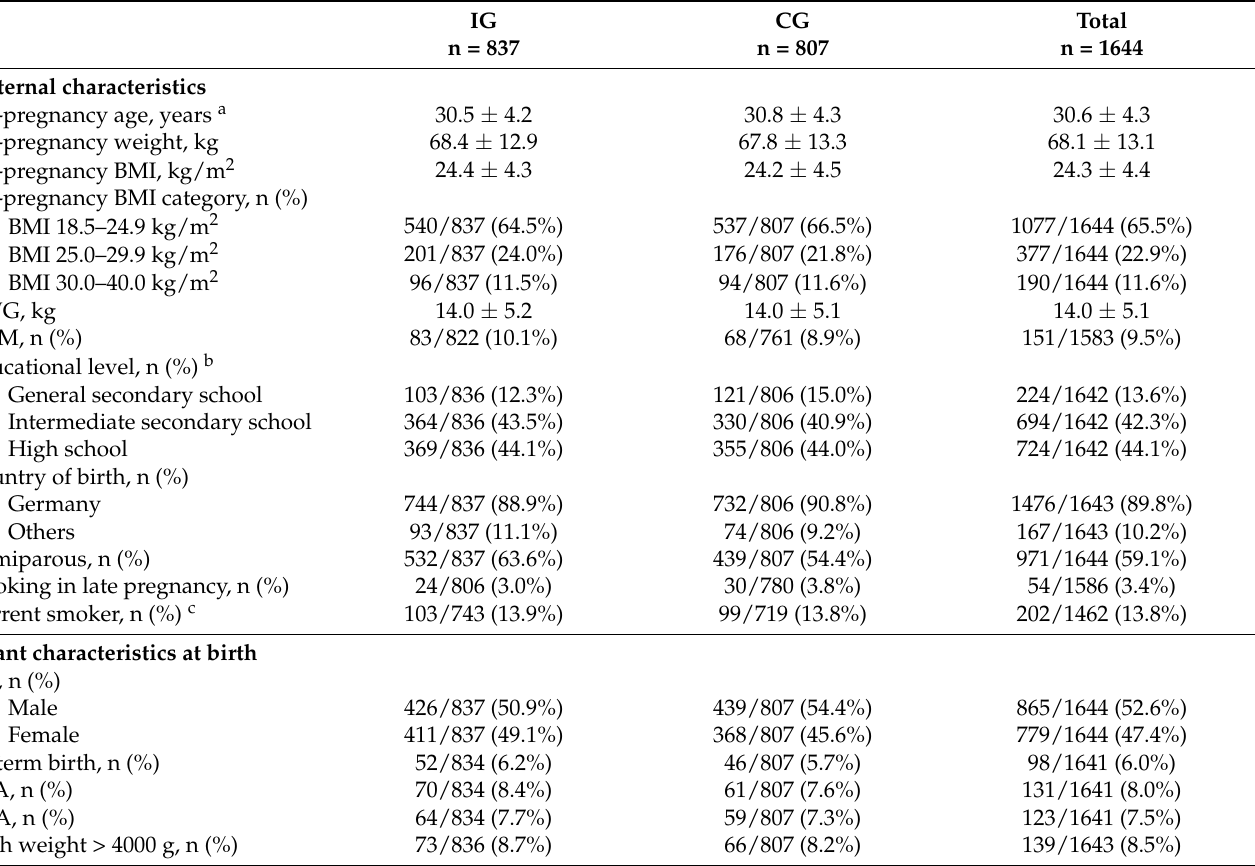
Table 1. Characteristics of mother-child